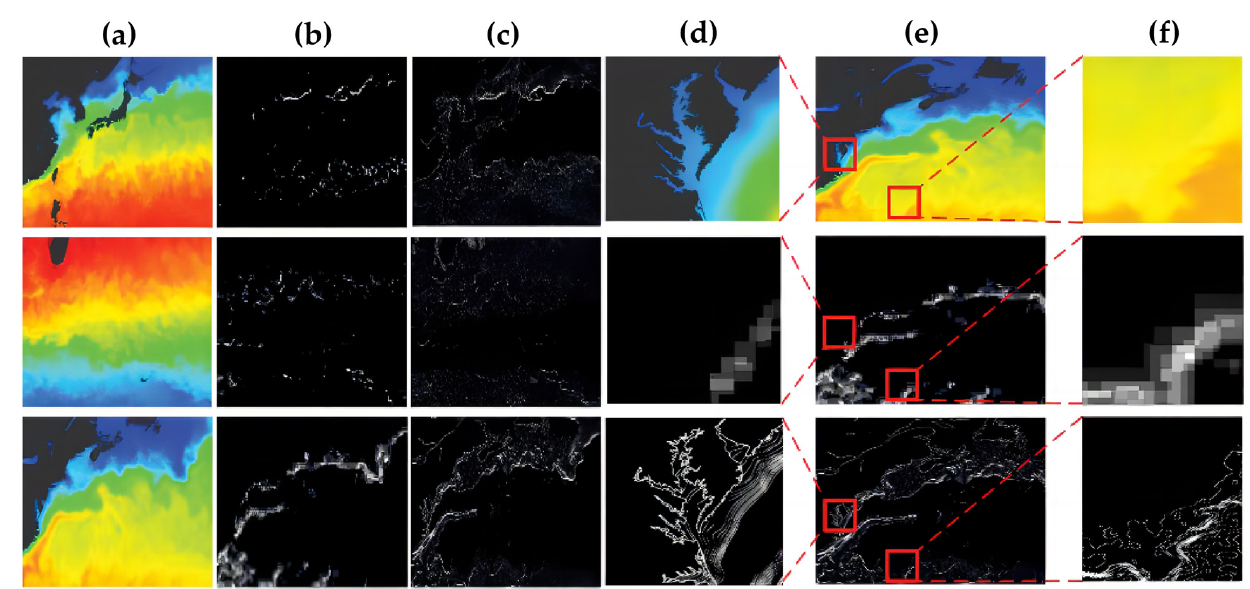
Figure 3. Comparison with the traditional method for ocean fronts detection [43]: ( a ) false color SST image; ( b ) multiscale deep framework (MDF); ( c ) traditional method; and ( d )–( f ) differences between MDF and the traditional